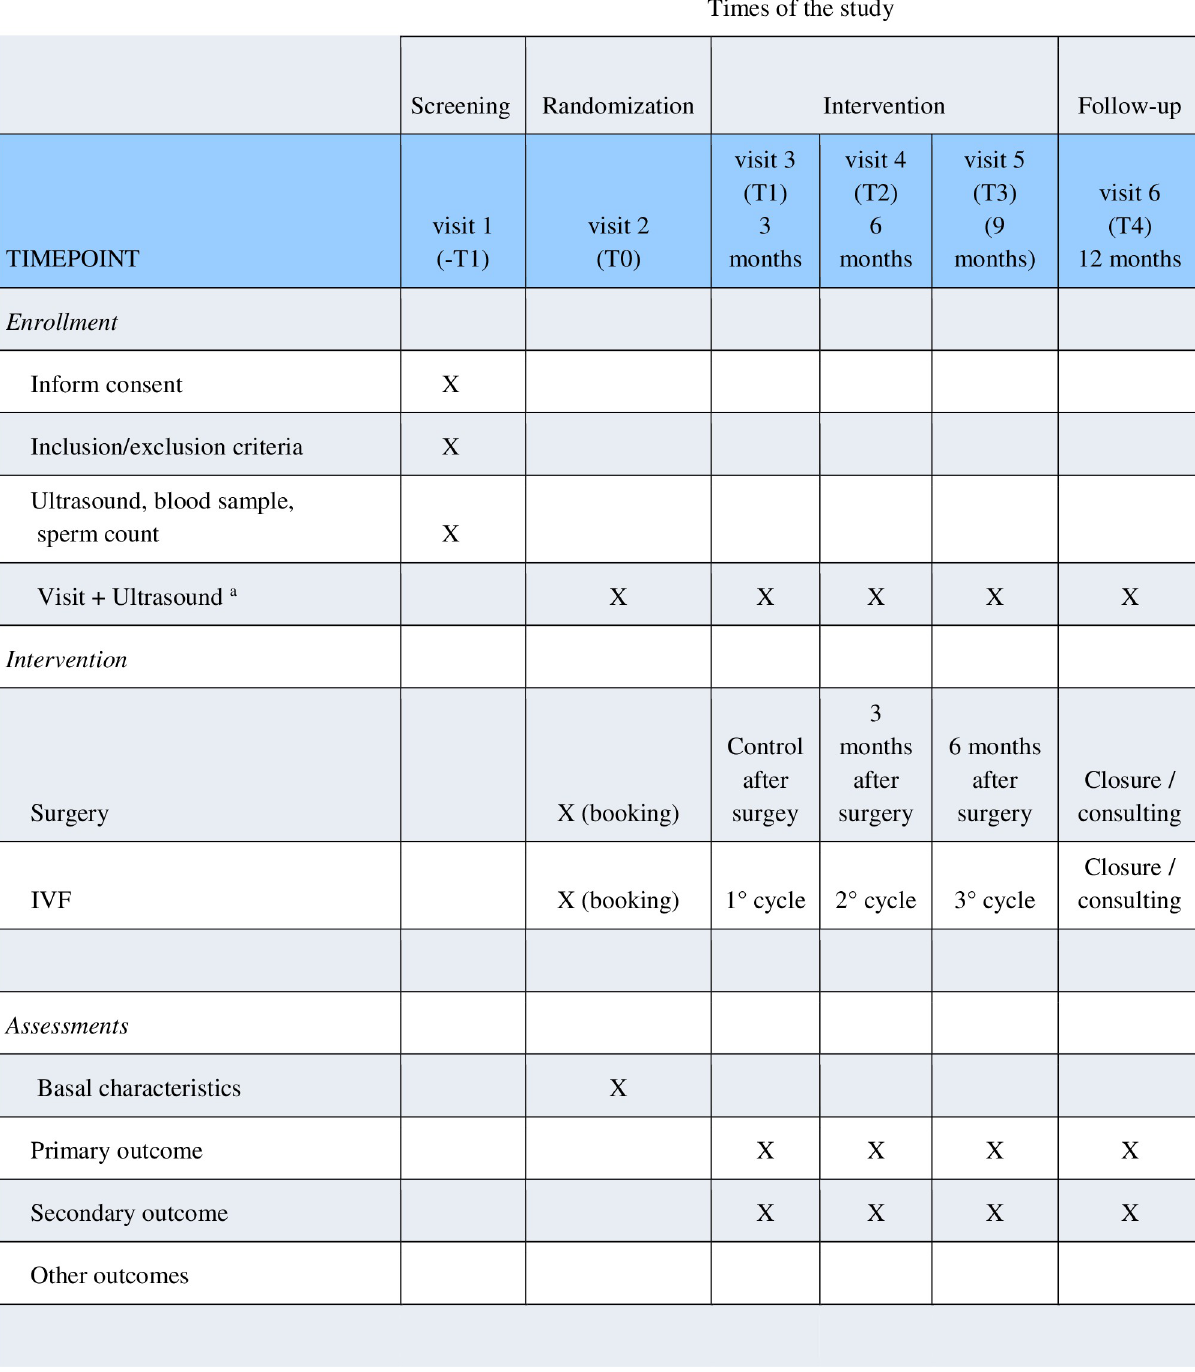
PLOS ONE | https://doi.org/10.1371/journal.pone.0271173 August 3,